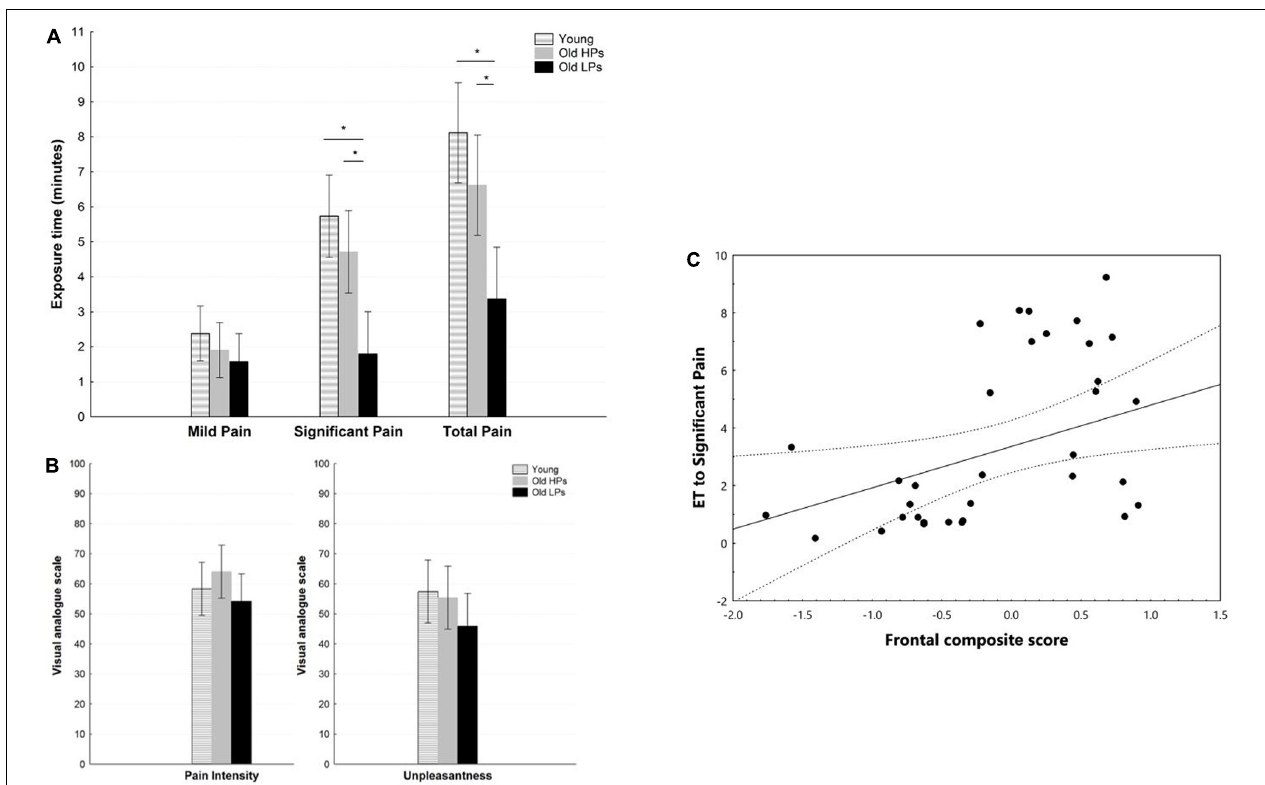
FIGURE 2 | Pain measures during pain tolerance tests. (A) Exposure time, (B) perceived pain ratings for pain intensity and unpleasantness, (C) correlation between frontal composite score and exposure time to significant pain. * p < 0.05 for post hoc analyses of paired